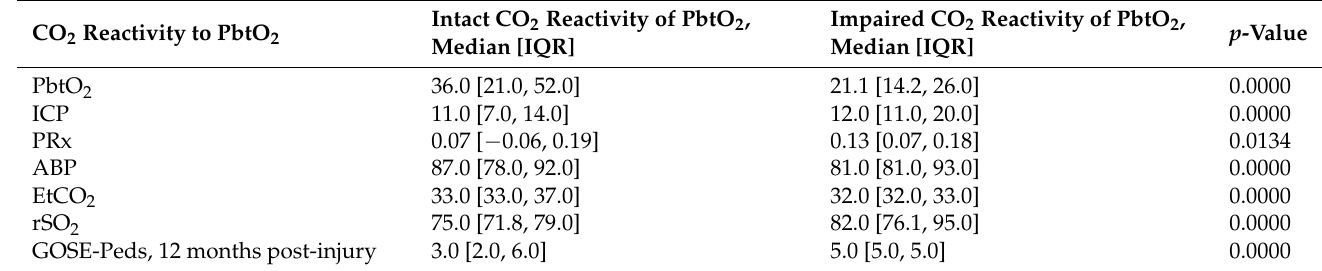
Table 5. Physiologic and Outcome Differences Between Patients with Intact and Impaired CO 2 Reactivity of PbtO 2